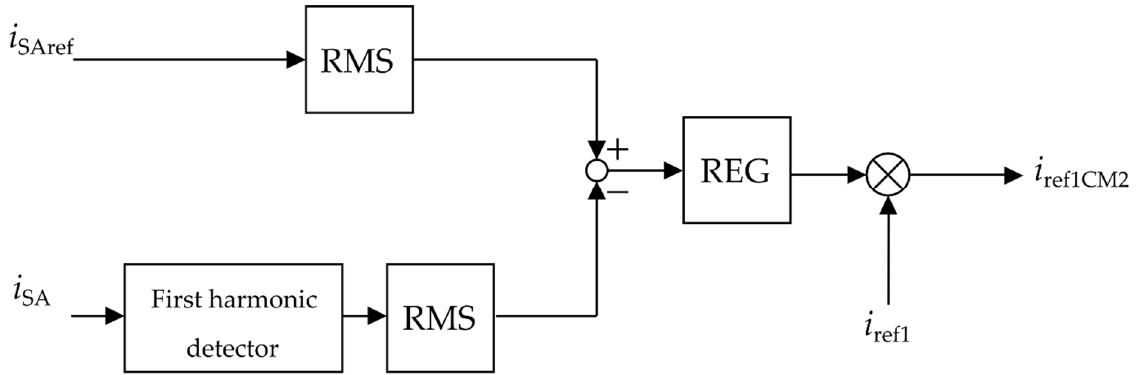
Figure 14. Block diagram of the algorithm that determines the amplitude of the reference signal of the CM 2 supporting system.